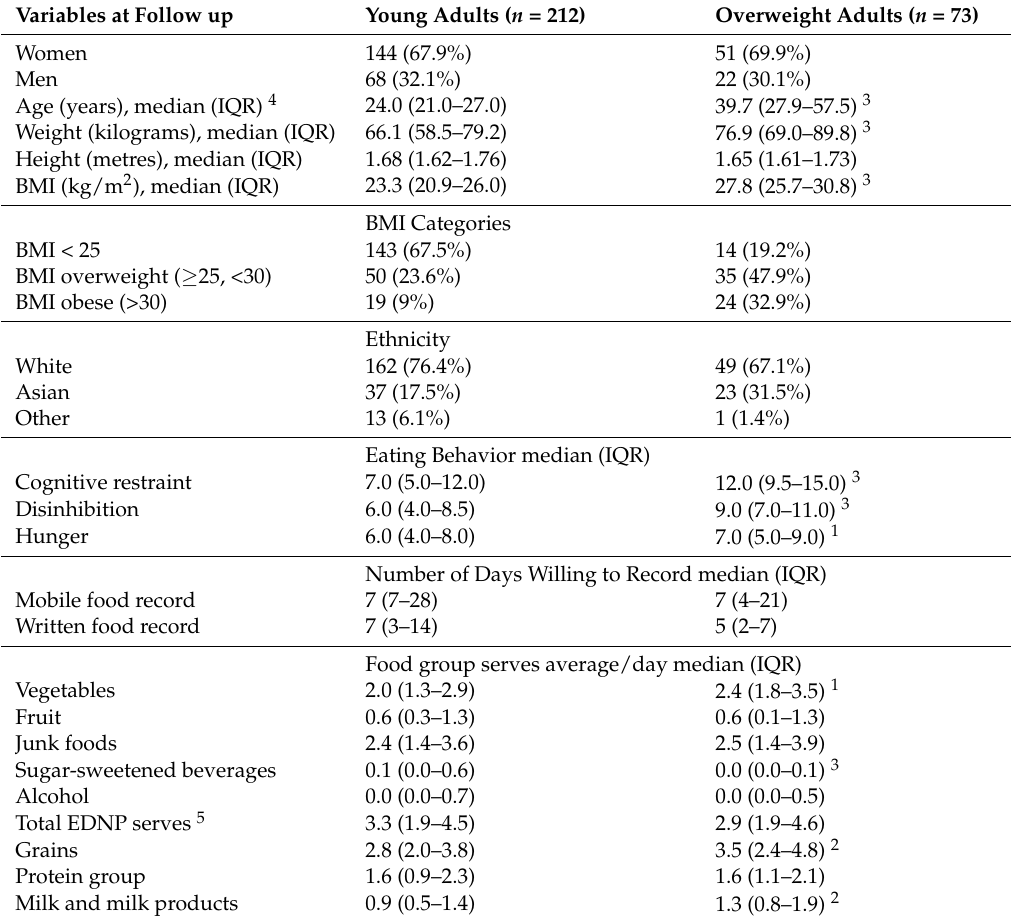
Table 1. Characteristics of participants comparing the young adult sample with the overweight adult sample testing the usability of the mobile food